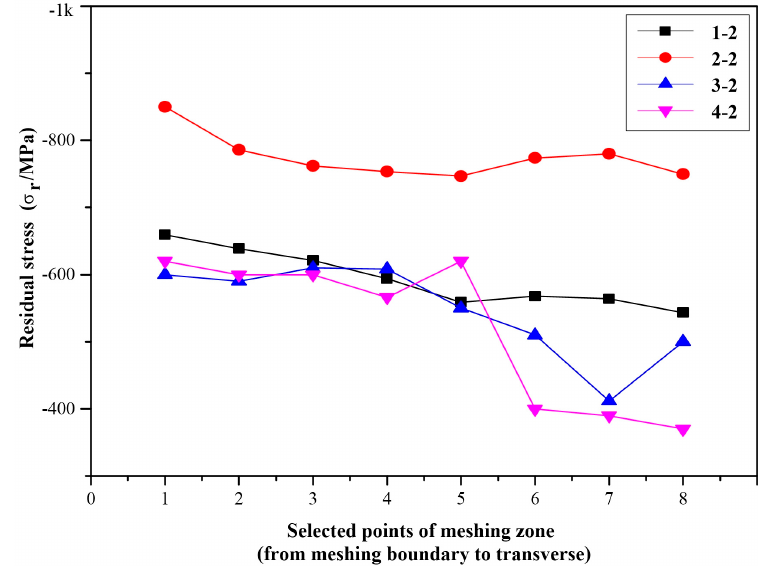
Figure 14. Variation in compressive residual stress along gear pitch circle H5.